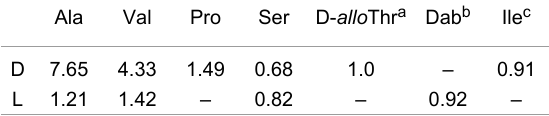
Table 1: The proportion of each enantiomer of each amino acid, which were determined by an amino acid analyzer and by the peak areas of the D- and L-amino acids as estimated by Marfey’s